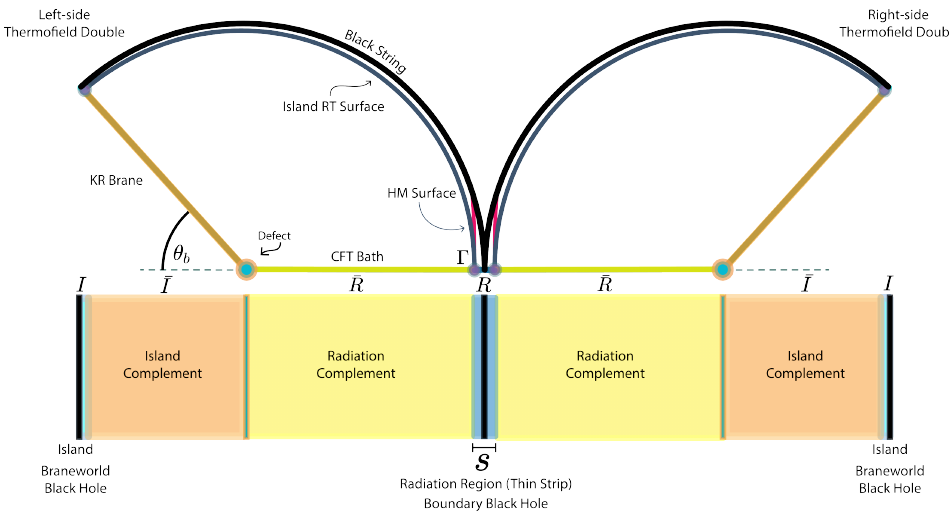
Figure 15 . Here we illustrate the doubly holographic black string setup for a small radiation region of width s . This corresponds to the limit Γ → 1 . The island region becomes infinitesimally small as well; this is consistent with the Russian doll